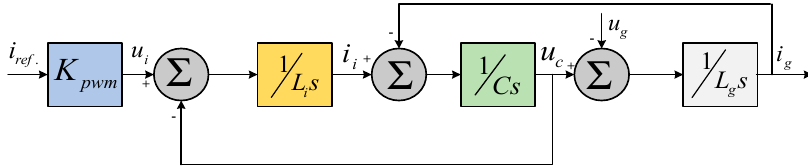
Figure 14. One-leg block diagram of a single-phase grid-connected system.